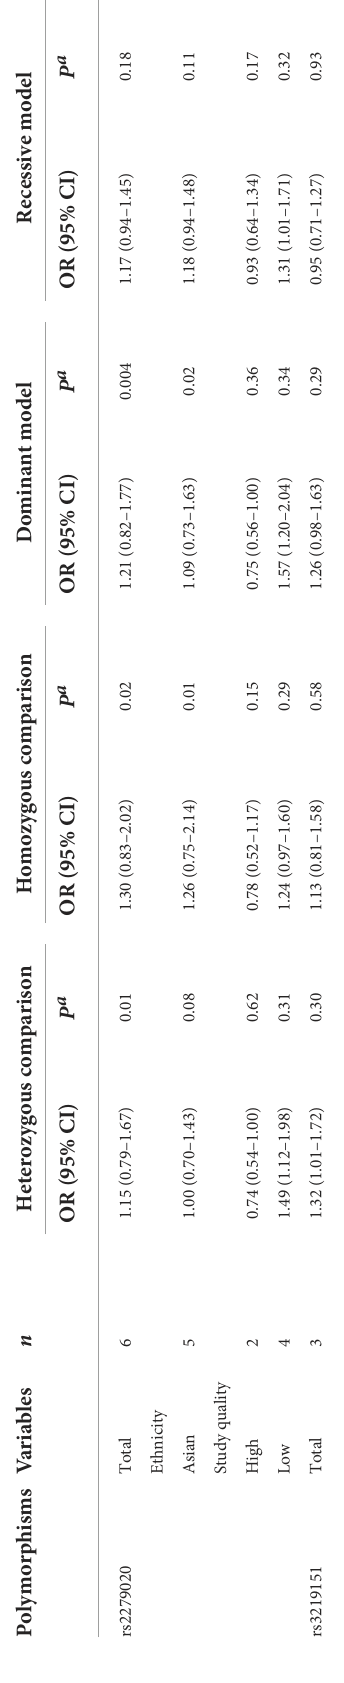
For the GABRA1 rs2279020 polymorphism, six studies were included involving 1,860 patients. High heterogeneity among studies was observed in overall analysis rather than in subgroup analysis based on study quality. The meta-regression analysis also showed that study quality can explain all the heterogeneity under heterozygous comparison and dominant genetic model. There was no significant association of the GABRA1 rs2279020 polymorphism with resistance to AEDs in the overall pooled populations and Asians. As a matter of interest, a significant association of the GABRA1 rs2279020 polymorphism with resistance to AEDs was observed in low- quality studies (heterozygous comparison: OR = 1.49, 95% CI, 1.12–1.98; dominant model: OR = 1.57, 95% CI, 1.20–2.04; recessive model: OR = 1.31, 95% CI, 1.01–1.71) but not in the high-quality studies (Table 3, Figure 2C), indicating that the negative results may be more reliable. For the GABRA6 rs3219151 polymorphism, three studies were included involving 1,202 patients. A borderline significant association of the GABRA6 rs3219151 polymorphism with resistance to AEDs was detected under a heterozygous Figure 2D).